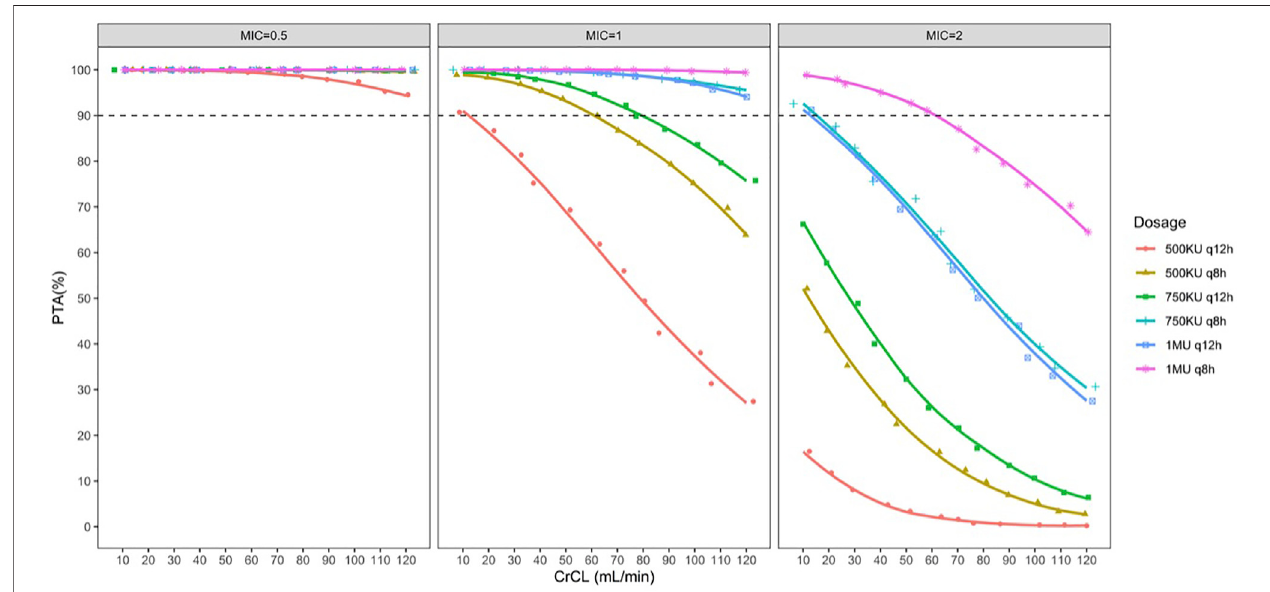
FIGURE 3 | Simulated probability of achieving target attainment (fAUC/MIC ≥ 15) of colistin sulfate at each MIC ( μ g/ml) for different dose regimens in patients with various CrCL volumes.